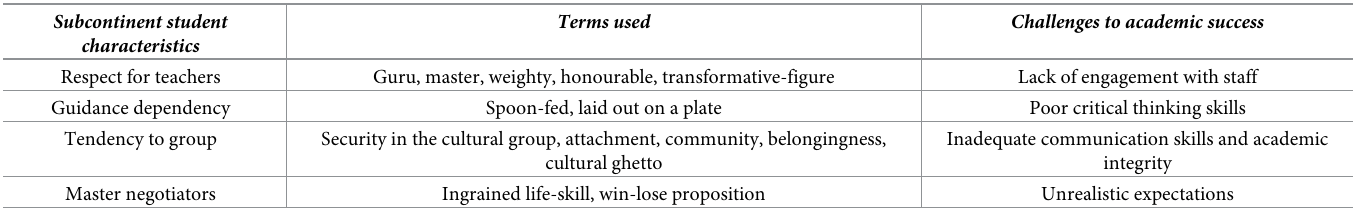
Table 1. Staff perceptions: Mapping student cultural characteristics and challenges to academic success. Subcontinent student